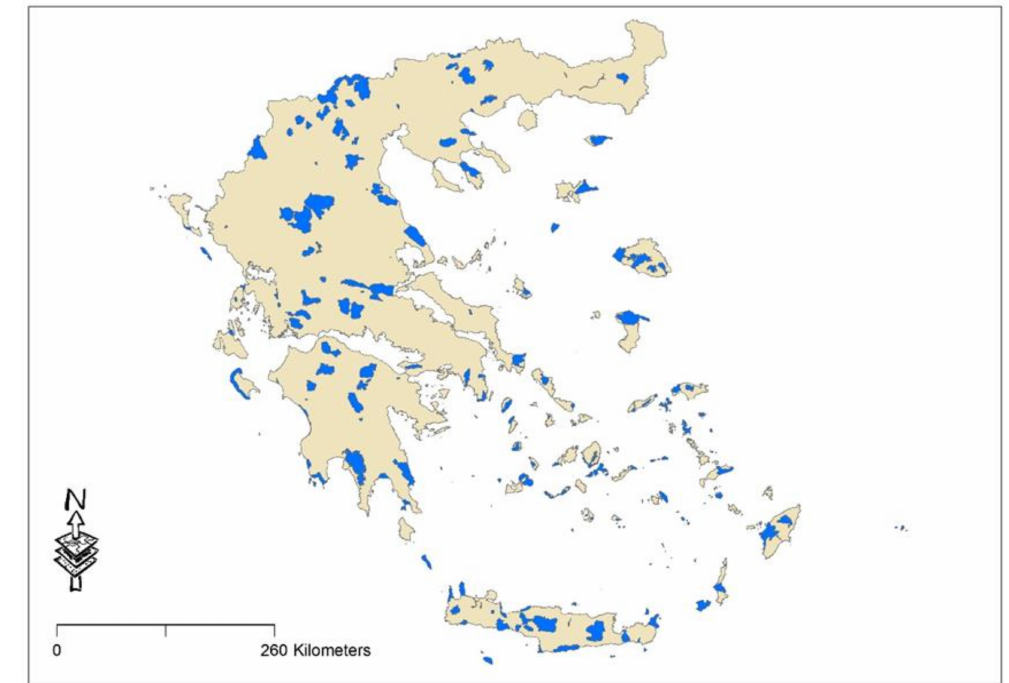
Figure 3. The 159 Natura 2000 sites under